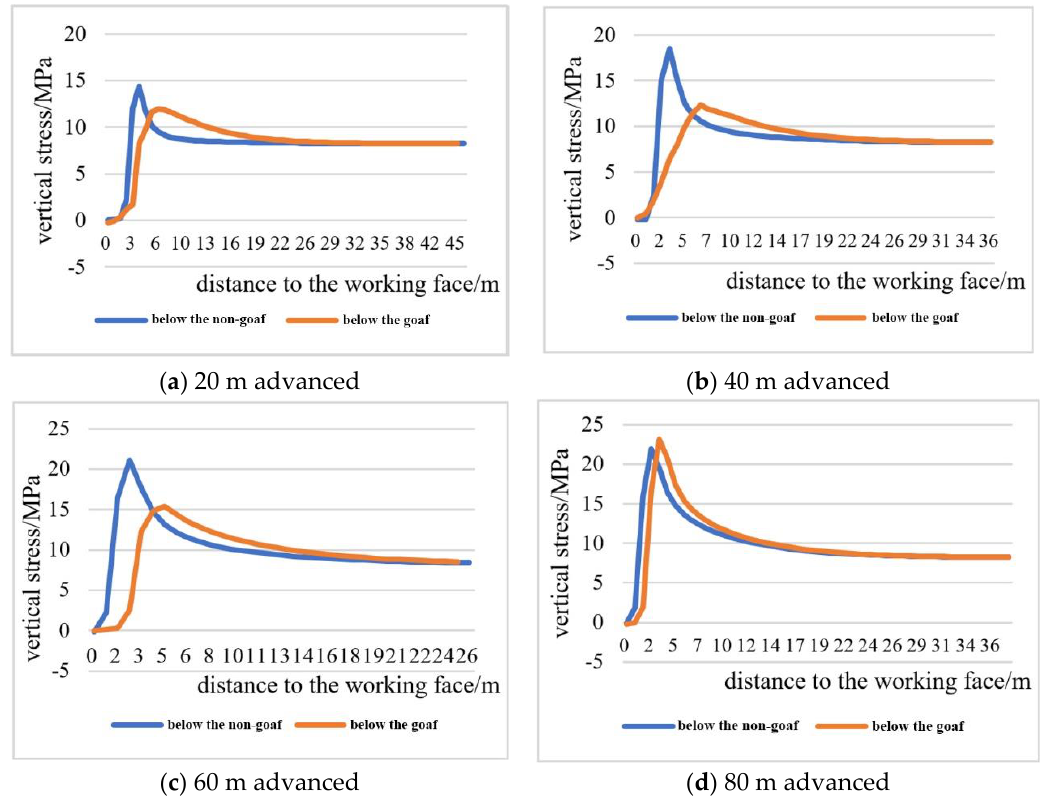
Figure 6. Diagram of vertical stress in front of the working face below the goaf and non-goaf.